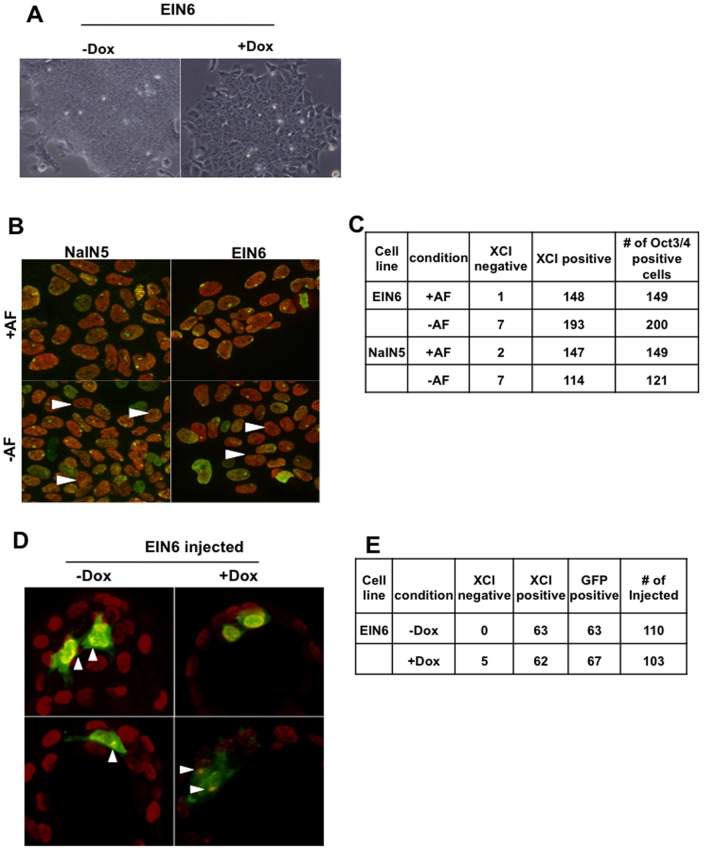
Effects of E-cadherin transgene expression on X-inactivation status.A) Morphology of EpiSCs with or without induction of E-cadherin upon addition of doxycycline (-Dox and +Dox). B) The X-inactivation status of Nanog-induced (NaIN5) or E-cadherin-induced (EIN6) EpiSCs. The Nanog or E-cadherin transgene was induced with doxycycline for 2 days with or without Activin and Fgf2 (+AF or –AF) and stained with H3K27me3 (shown in green) and Oct3/4 (shown in red). White arrowheads indicate inactive X chromosome (XCI)-negative cells. C) Measurement of the ratio of XCI-negative and -positive cells in Figure 3B. Only Oct3/4-positive cells were counted in each case. Note that NaIN and EIN cells maintained 100% XCI in EpiSC medium without doxycycline (data not shown). D) E-cadherin induced EpiSCs lost XCI in injected blastocysts cultured for 36 h. EpiSCs induced by E-cadherin for 2 days were injected into blastocysts with the single-injection protocol. The embryos were then cultured for 36 h followed by immunostaining with H3K27me3 antibody to estimate reprogramming events in developing embryos. EGFP-positive cells (green) and H3K27me3-positive (red) cells were counted in injected embryos. E) Measurement of the ratio of XCI-positive and negative cells in Figure 3D. Only GFP positive cell were counted (p<0.05 between each pair).